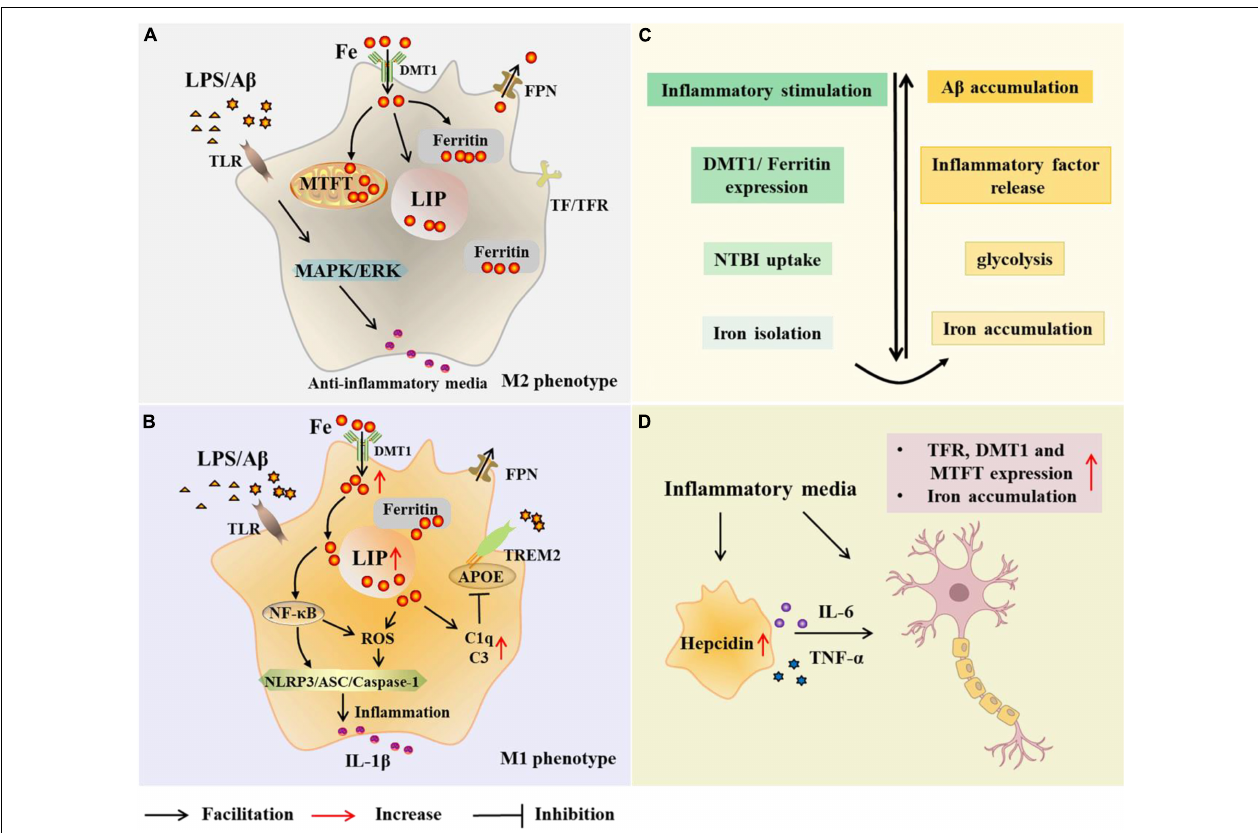
FIGURE 2 | Microglial modulations on iron metabolism in Alzheimer’s disease (AD). In the case of AD, microglia are exposed to elevated iron levels, LPS, as well as the extracellular A β released from damaged neurons. The expression of DMT1 and ferritin is up-regulated in M2 microglia, which preferentially increases NTBI uptake, expands iron storage in ferritin and mitochondrial ferritin, and isolates extracellular and intracellular iron (A,C) . With high iron intake, microglia LIP increases, and iron and its induced ROS activate inflammasome, releasing inflammatory factors and promoting neuroinflammation (B) . Iron upregulates C3 and C1q expression and inhibits the APOE-TREM2 axis, leading to reduced phagocytosis of A β plaques (B) . Iron accumulation increases TNF- α expression and glycolysis, and reduces microglial phagocytosis (C) . Microglia alter neuronal iron homeostasis in neuroinflammation. Increased hepcidin in microglia and released inflammatory factors promote iron accumulation in neurons by affecting iron uptake and storage (D) . AD, Alzheimer’s disease; A β ,amyloid beta-protein; LPS, lipopolysaccharide; TLR, toll-like receptor; DMT1, divalent metal transporter 1; FPN, ferropoiin; C1q, complement 1q; TfR, transferrin receptor; NTBI, non-transferrin-bound iron; MTFT, mitochondrial ferritin; IFN- γ , interferon γ ; NF- κ B, nuclearfactor-kappa B; ROS, reactive oxygen species; MAPK, mitogen activated protein kinase; ERK, extracellular regulated protein kinases; APOE, apolipoprotein E; TREM2 triggering receptor expressed on myeloid cells 2; ASC, apoptosis-associated speck-like protein containing a CARD; NLRP3, NLR family pyrin domain containing 3; TNF- α , tumor necrosis factor- α ; IL-6,